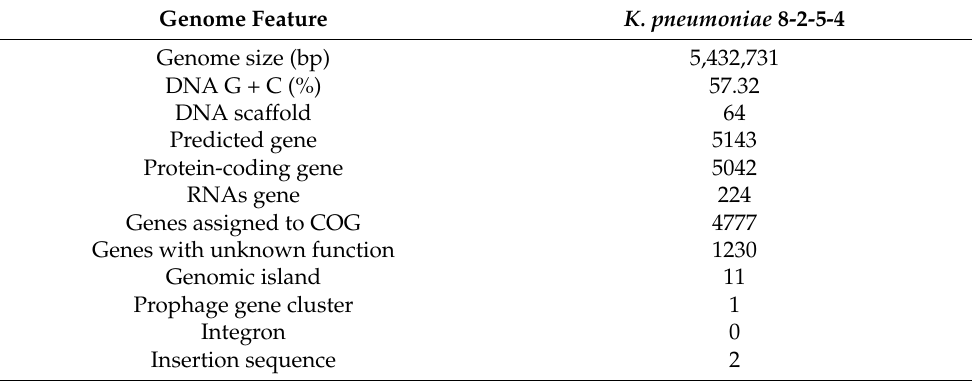
Table 5. Genome features of K. pneumoniae 8-2-5-4 isolate recovered from T. granosa